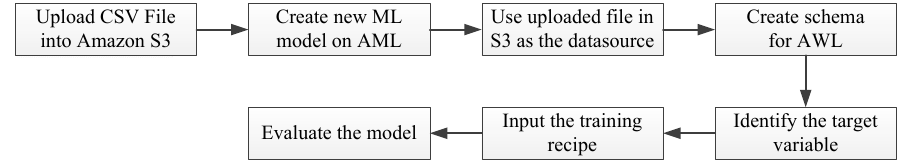
Figure 8. The process flow for model creation on the Amazon Web Services Machine Learning (AML).